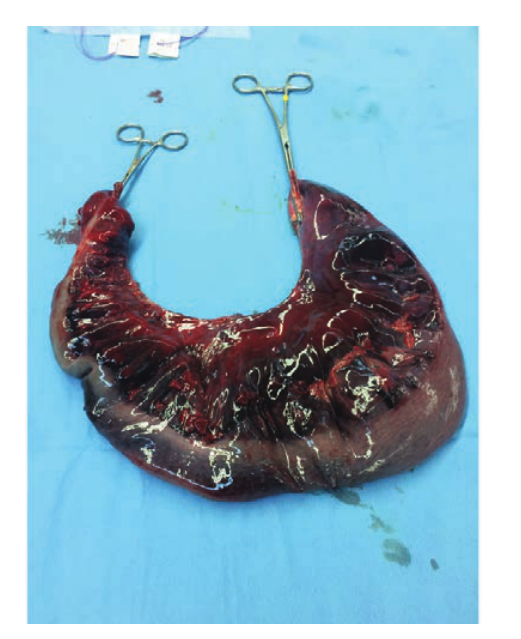
Figure 4. A sigmoidectomy with a primary end-to-end anasto- mosis of the descending colon with the upper rectum plus appen- dectomy were